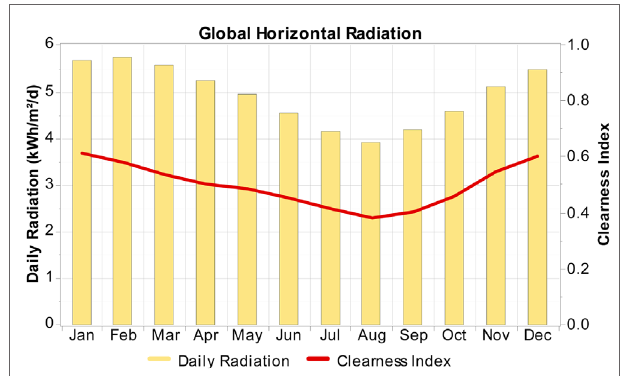
FigUre 3 | nsukka monthly mean daily radiation